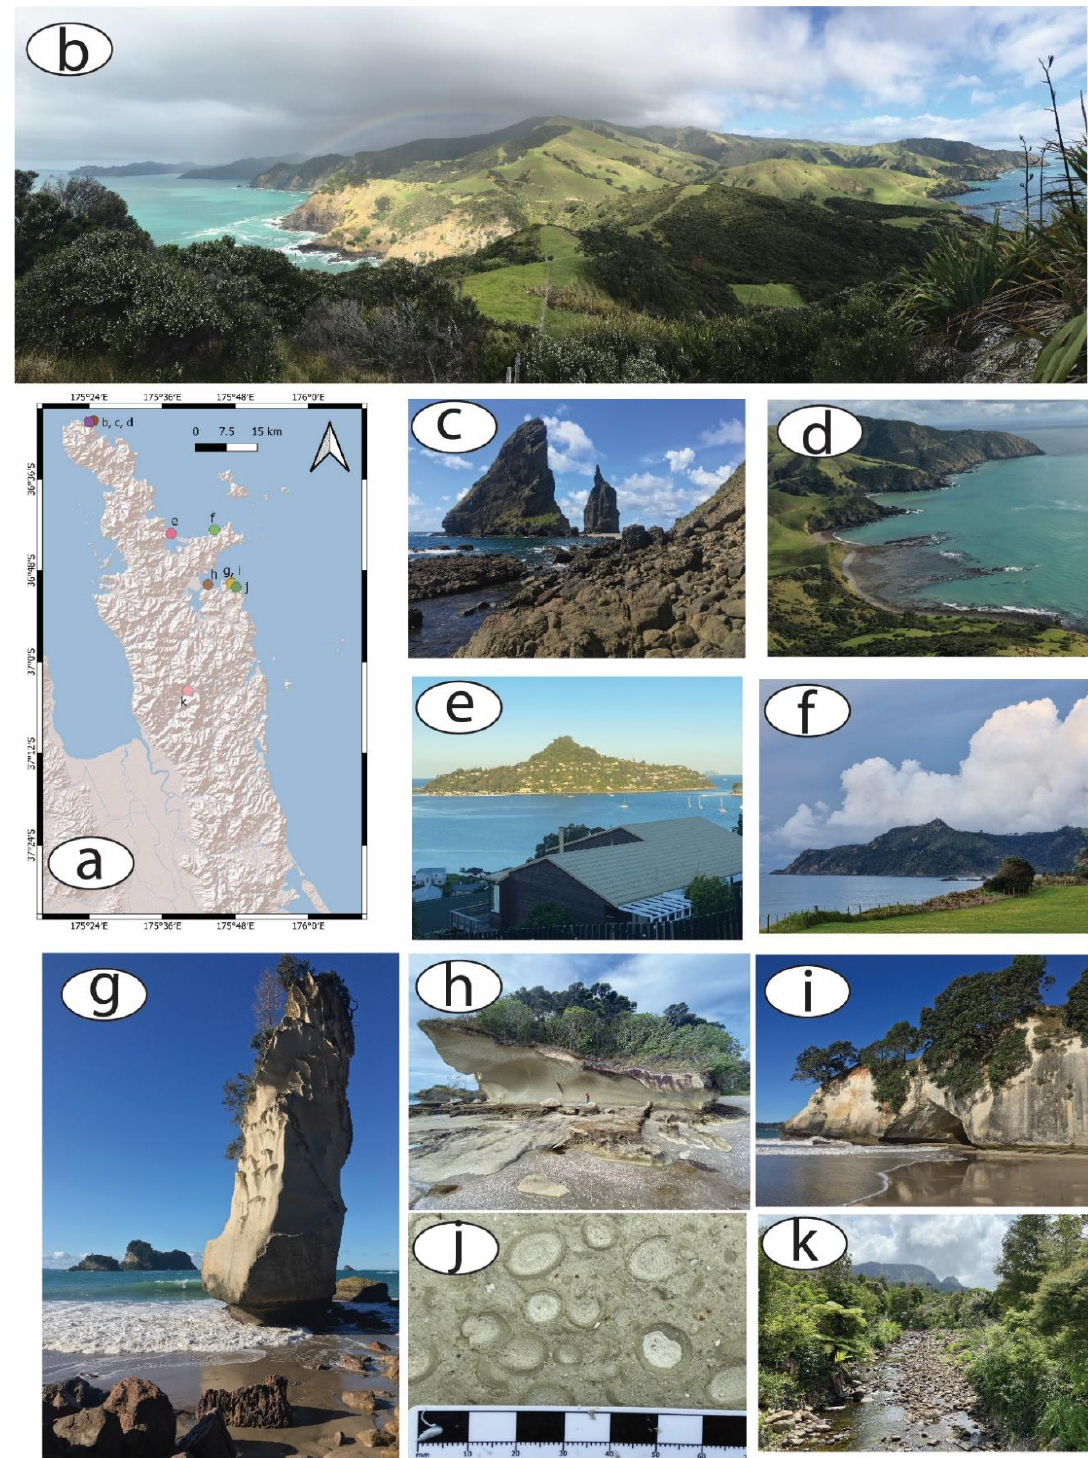
Figure 8. Selected geologically important and interesting sites with high geoheritage values shown on an ESRI Shaded relief map ( a ). These selected sites are compared with the geodiversity values our calculation showed. ( b ) The Fletcher Bay area in the northern Coromandel area generally falls in the high geodiversity zones; however, inland areas are more in the middle level of geodiversity values, which is consistent with the relatively simple geology and low relief of the region; ( c ) our geodiversity estimate picked up well on the local high geodiversity area of the half-section of andesitic